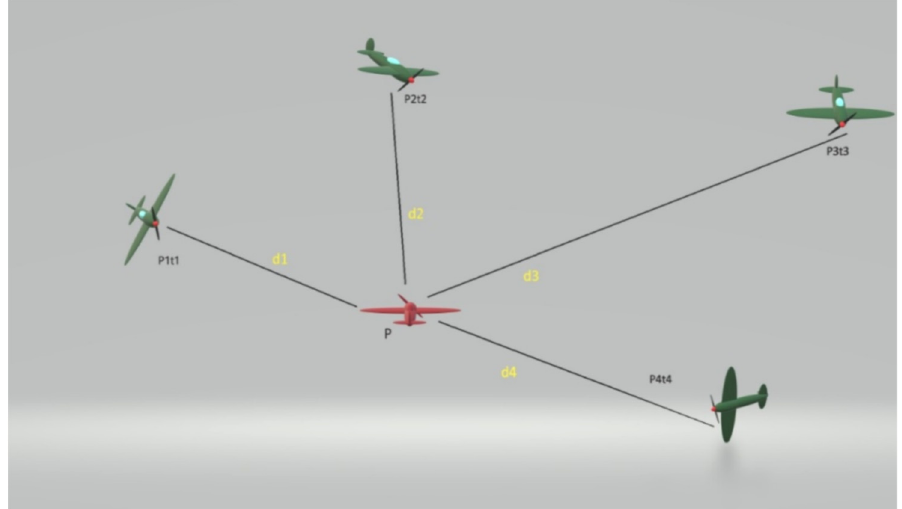
Figure 2. Position of the anti-collision system P concerning other users of the communication network. Figure 1 reflects an air situation in the aviation communication system. The used